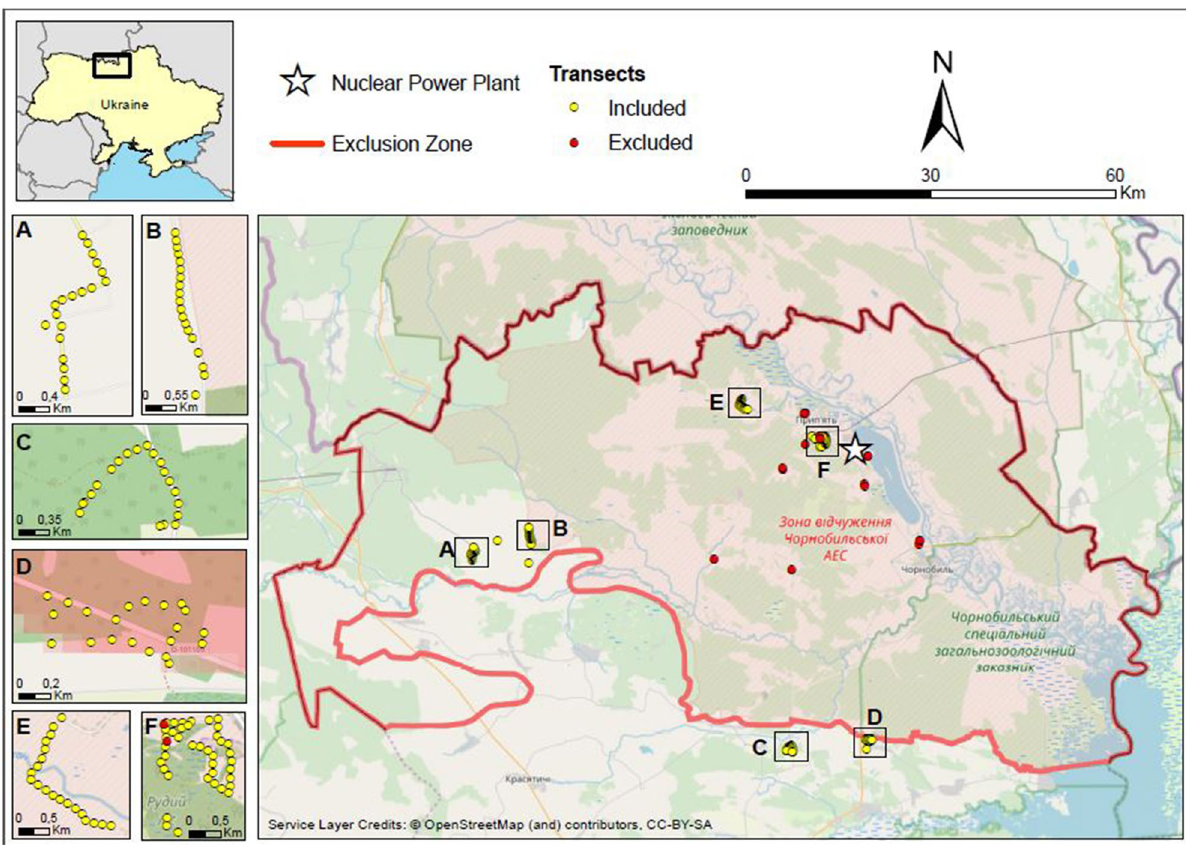
Figure 1. Location of the study sites in or near the CEZ. (Adapted from Møller and Mousseau 1 , and Open Street Map—circles: first point of each transect; red/yellow: excluded/re-analyzed, red line: limits of the